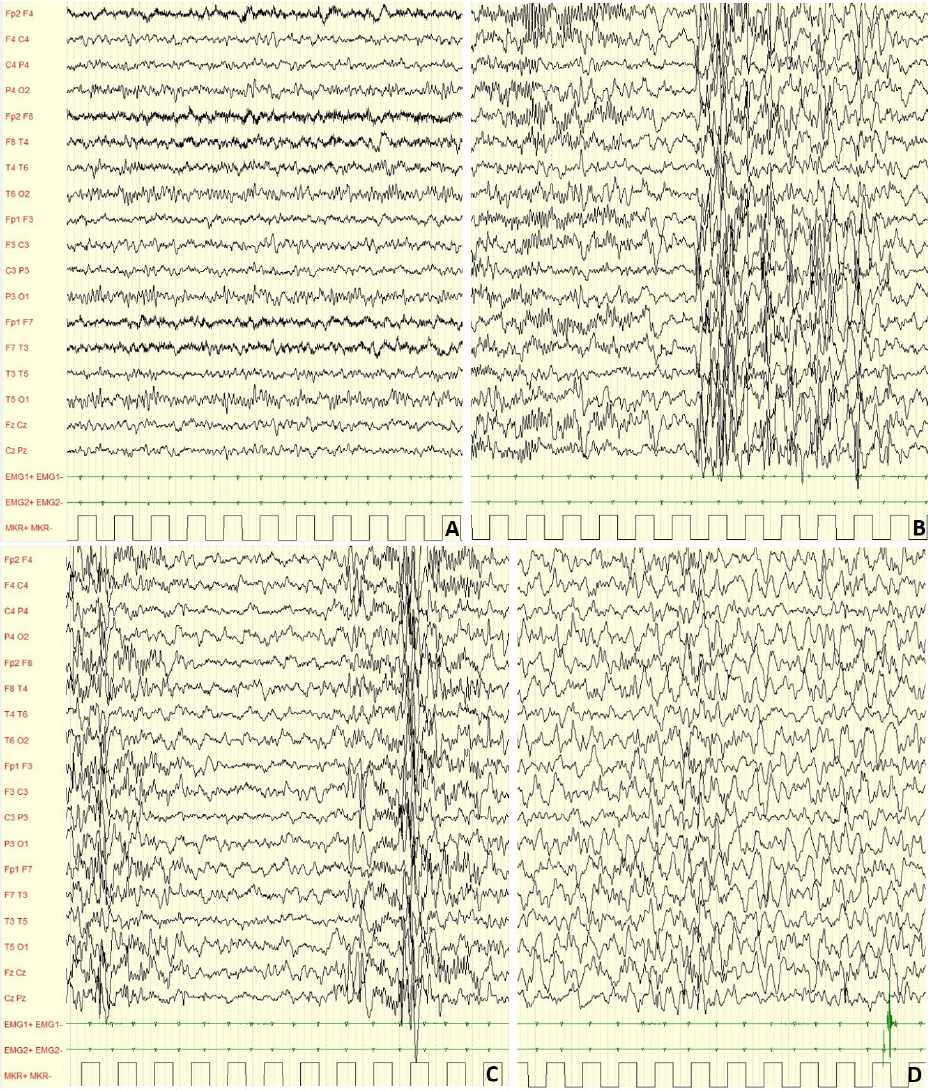
Figure 2. Male, 4 years-6 months PSG-EEG: ( A ) normal background activity in wakefulness; ( B , C ) PS-IEDs during NREM-2 phase of sleep; ( D ) reduction of PS-IEDs during NREM-3 phase of sleep.